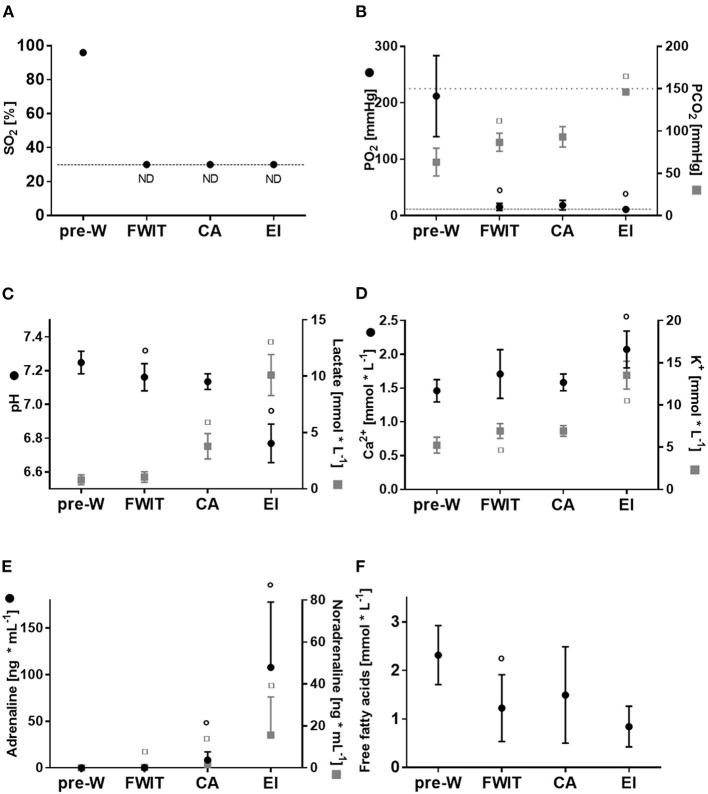
Blood parameters during in-situ/withdrawal phase. (A) Oxygen saturation (SO2) (B) partial oxygen and carbon dioxide pressure (PO2 and PCO2) (C) blood pH and lactate (D) blood calcium (Ca2+) and potassium (K+) (E) blood adrenaline and noradrenaline (F) blood free fatty acids. CA, circulatory arrest; EI, end-ischemia; FWIT, functional warm ischemia start; ND, below detection limit; pre-W, pre-withdrawal of life sustaining therapy. Data are expressed as mean ± standard deviation. Statistical analyses were only performed between consecutive time points. ° or □
p < 0.05 vs. corresponding previous time point. n = 8–21/time point.